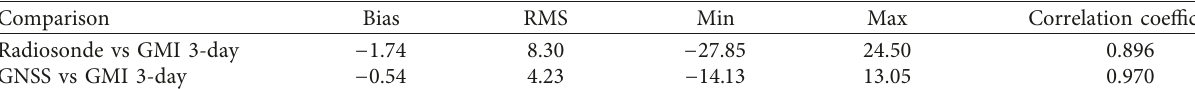
Figure 3: Scatter plots of (a) radiosonde PWV versus GMI 3-day PWV and (b) GNSS PWV versus GMI 3-day PWV, PDFs of PWV difference between (c) radiosonde and GMI 3-day and (d) GNSS and GMI 3-day, and fractional errors as percent by (e) radiosonde and (f) 5mm PWV bins. Table 1: Statistical results (unit: mm) for the comparisons between radiosonde and GMI 3-day and GNSS and GMI 3-day.